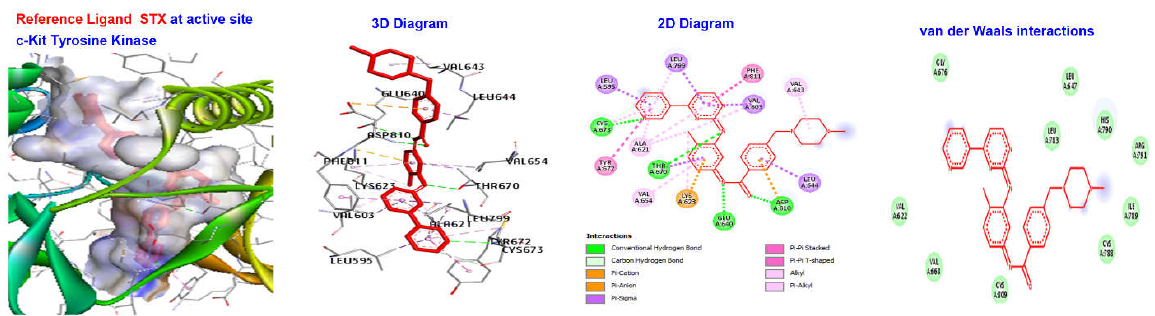
Figure 6. Binding interactions of reference ligand (STI) with Protein c-Kit Tyrosine Kinase binding pocket.